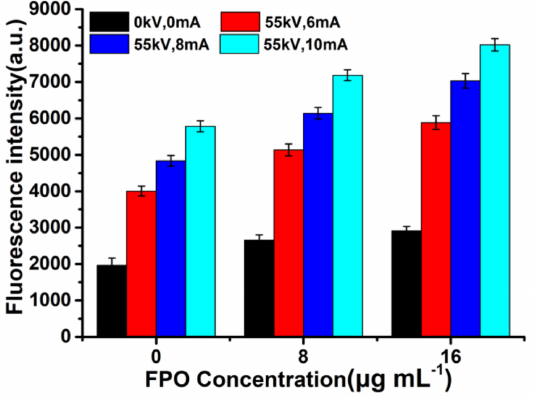
Figure 5. Comparison of fluorescence intensity of FPO@HMSNs-PAA (the FPO concentration of 0, 8, and 16 µ g · mL − 1 ) treated with different radiotherapy (RT) intensity (55 kV, 6 mA; 55 kV, 8 mA; 55 kV, 10 mA) in PBS (pH 6.50). It reflected the ROS